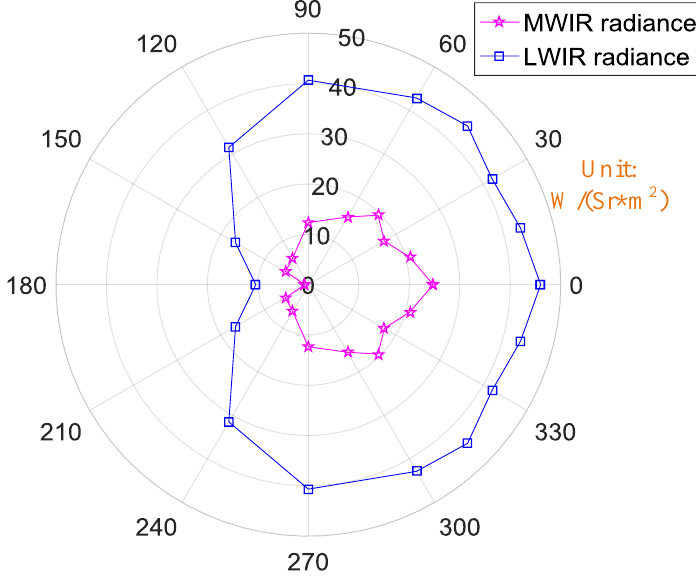
Figure 17. Orientation map of the UAV’s radiance in different IR bands.